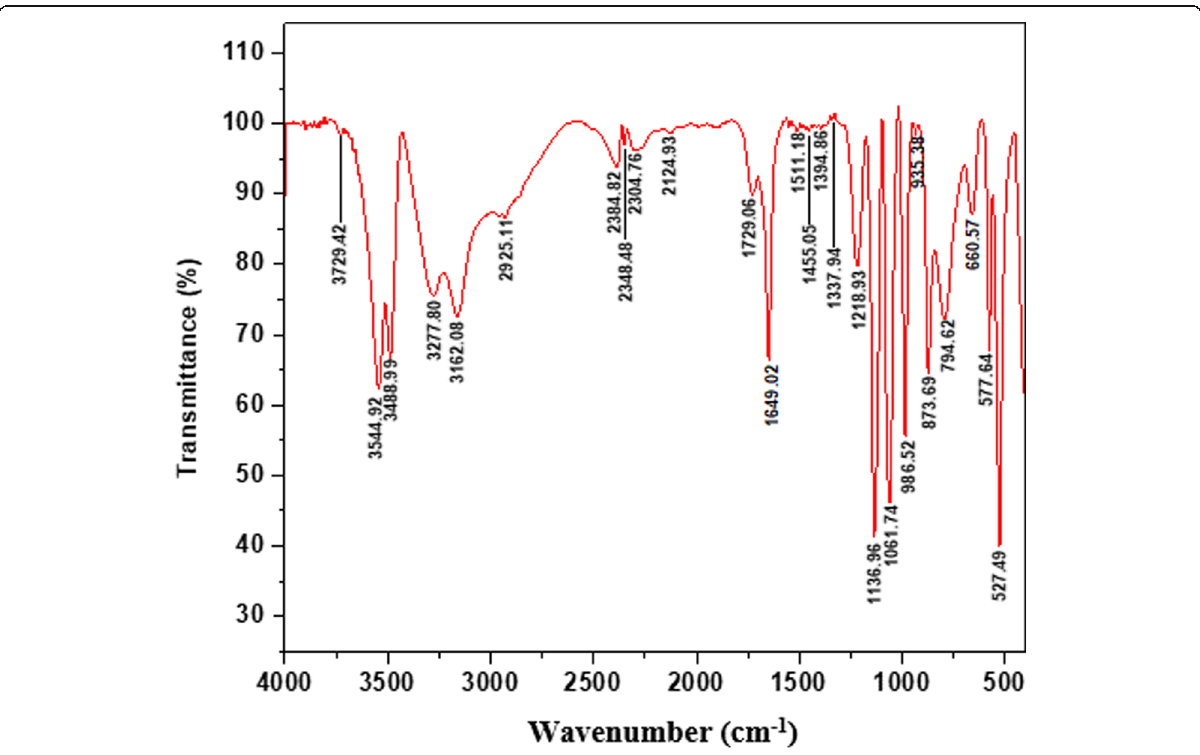
Fig. 7 FTIR spectrum of undoped CHPD crystal